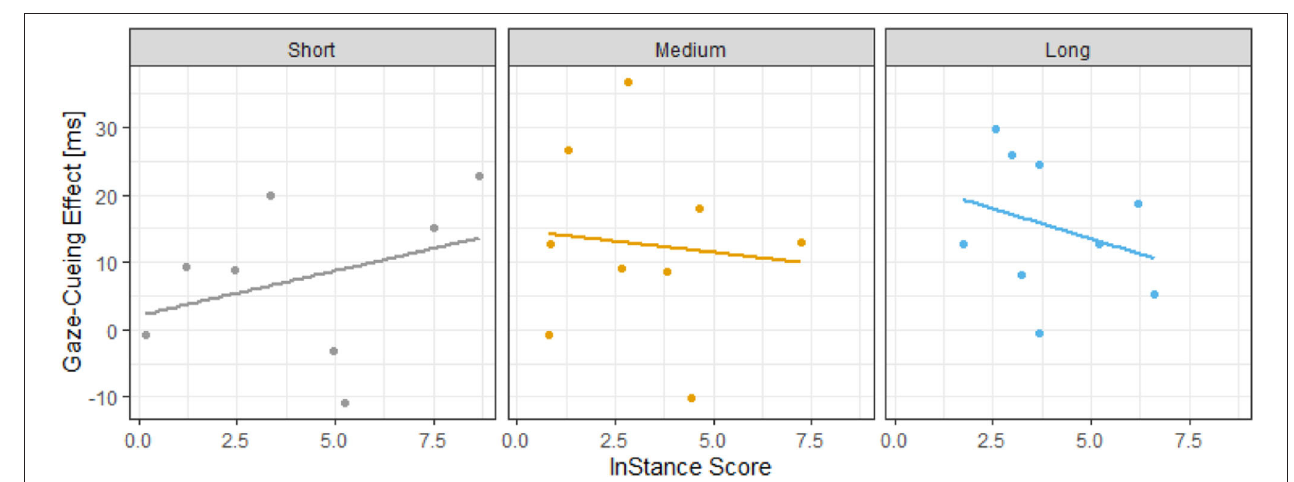
FIGURE 4 | Interaction between exposure and Pre-ISQ scores in GCE. The graph illustrates that an interaction is evident between the length of exposure and Pre-ISQ scores. The interaction shows a positive correlation between ISQ scores and GCE when exposure length is short; however, this relationship becomes more negative as exposure length